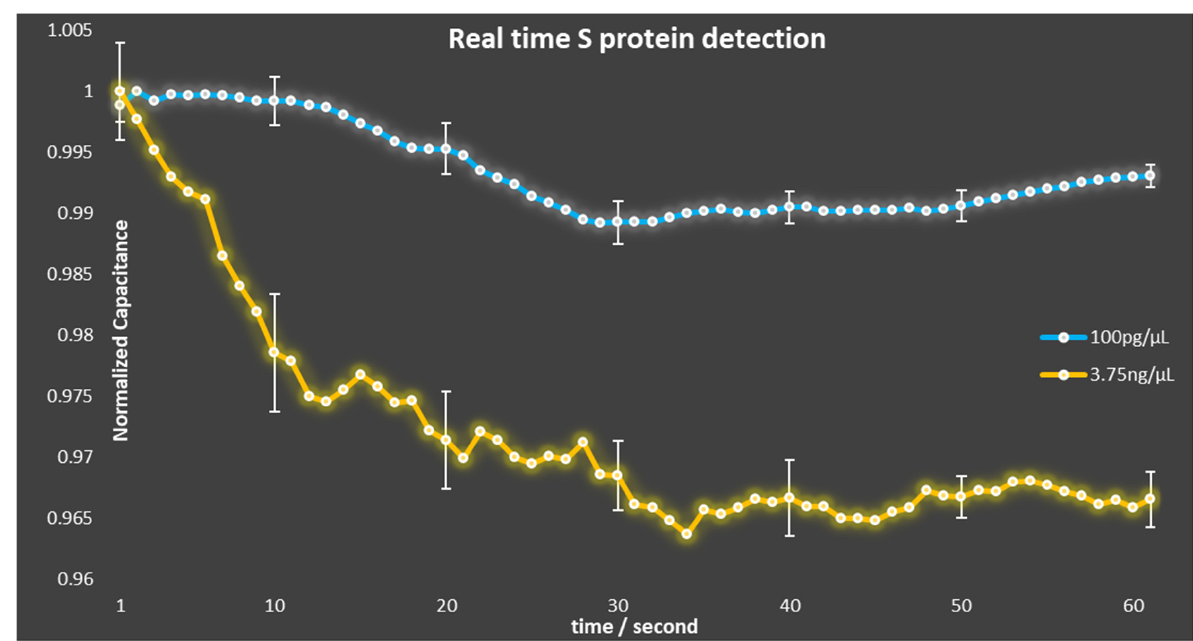
Figure 6. Normalized capacitance change over time due to the binding of S protein.